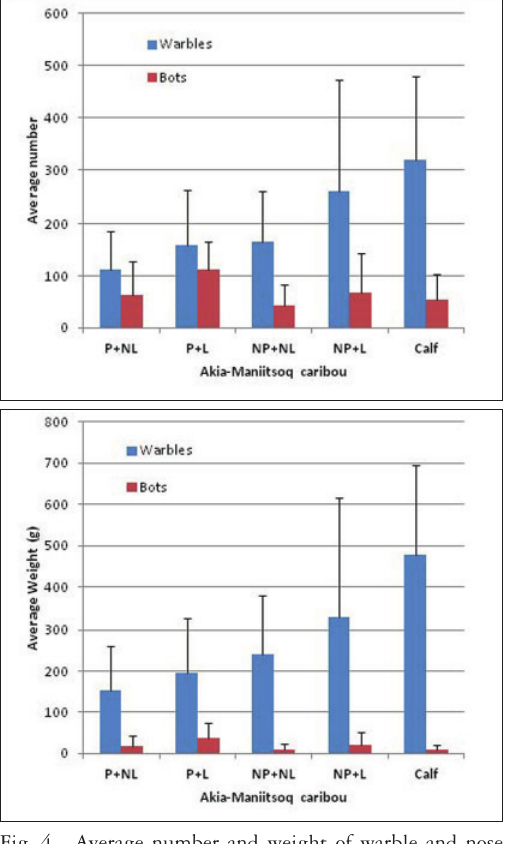
Fig. 5. Average number and weight of warble and nose bot larvae in Kangerlussuaq-Sisimiut caribou, March 2009 in West Greenland: pregnant & not-lactating (P+NL) n = 12; pregnant & lac- tating (P+L) n = 8; not-pregnant & not-lactat- ing (NP+NL) n = 6; not-pregnant & lactating (NP+L) n = 14; calf n =